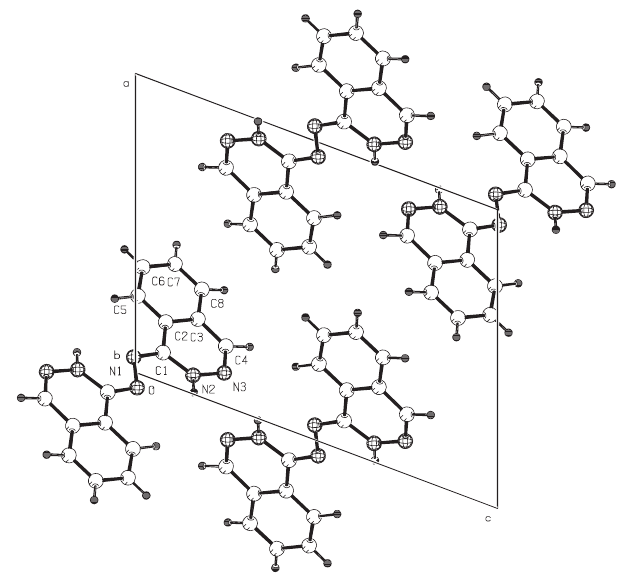
Table 1. Data collection and handling.